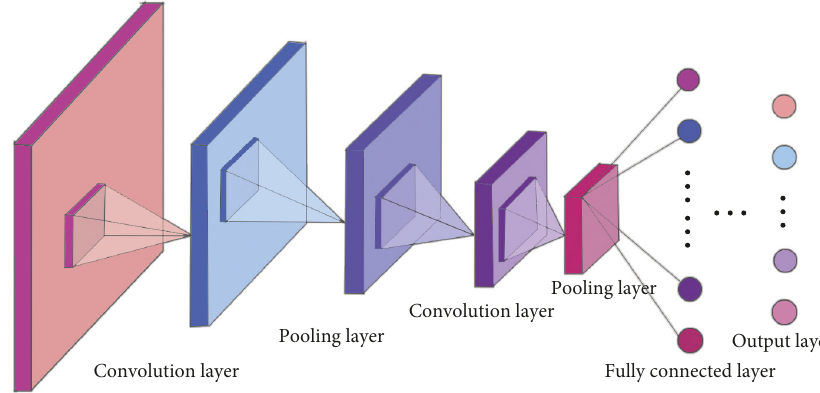
Figure 1: Typical convolutional neural